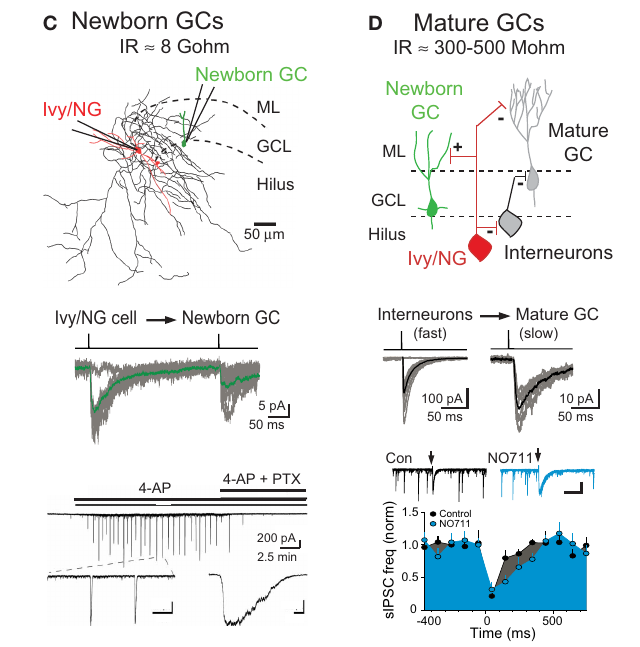
FIGURE 2 | Modes of GABAR signaling during GC development. (A) Tonic signaling to Type I radial glial-like stem cells: Top, schematic depiction of whole cell patch clamp recording from mature granule cells (mGCs) or Type I GFP + radial glial-like stem cells (RGLs) during photoactivation of PV + interneurons expressing channelrhodopsin (ChR2). Middle, photoactivation of ChR2 + PV + interneurons (indicated by blue lines, 1Hz) generates large synaptic currents in mature GCs that are blocked by the GABAR antagonist bicuculline (Bic). Bottom, photoactivation of ChR2 + PV + interneurons (blue bar, 8Hz) generates small tonic currents in Type I RGLs that are blocked by bicuculline. Adapted from Song et al. (2012) with permission from Macmillan Publishers Ltd. Estimates for input resistance (IR) of Type I and Type II cells are from Fukuda et al. (2003). (B) Synaptic signaling to Type II neuroprogenitors: Top, schematic depiction of innervation of Type II cells by dentate interneurons. Middle, hilar stimulation evokes inward currents in Type II cells that are blocked by bicuculline. Bottom, the frequency of spontaneous activity in Type II cells is increased by bath application of 4-aminopyridine (4-AP; 100 μ M), a potassium channel blocker that causes synchronous firing of dentate interneurons (Michelson and Wong, 1994; Markwardt et al., 2011). 4-AP-induced currents are blocked by tetrodotoxin (TTX). Insets show currents on an expanded time scale. Adapted from Tozuka et al. (2005) with permission from Elsevier. (C) Synaptic signaling to newborn GCs by Ivy/NG interneurons: Top, reconstructed Ivy/NG interneuron (red cell body